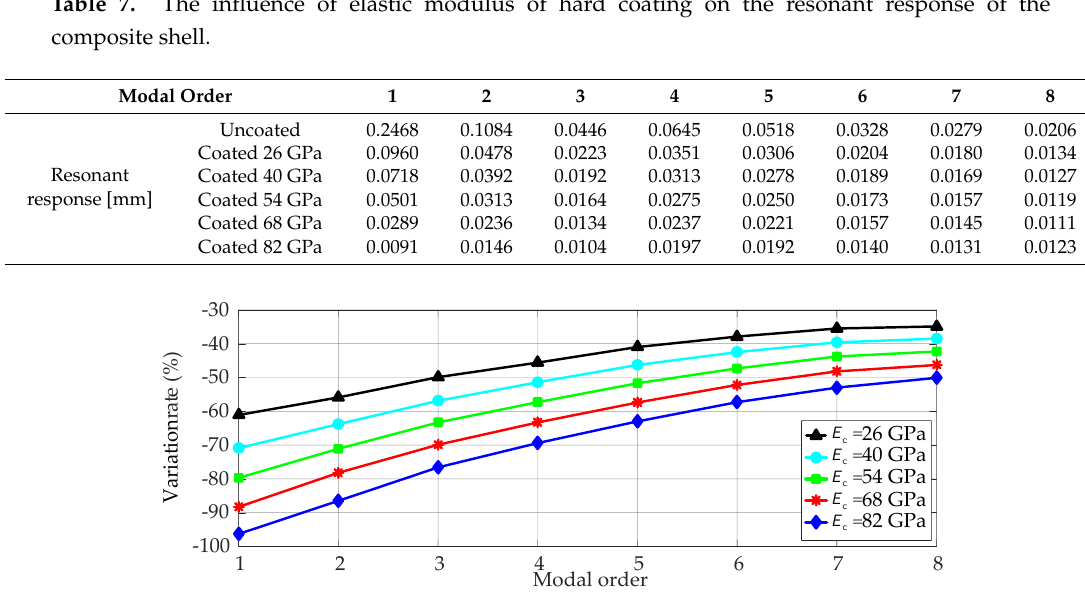
Figure 4. The variation rate of resonant response of the composite shell corresponding to different elastic modulus of hard coating.